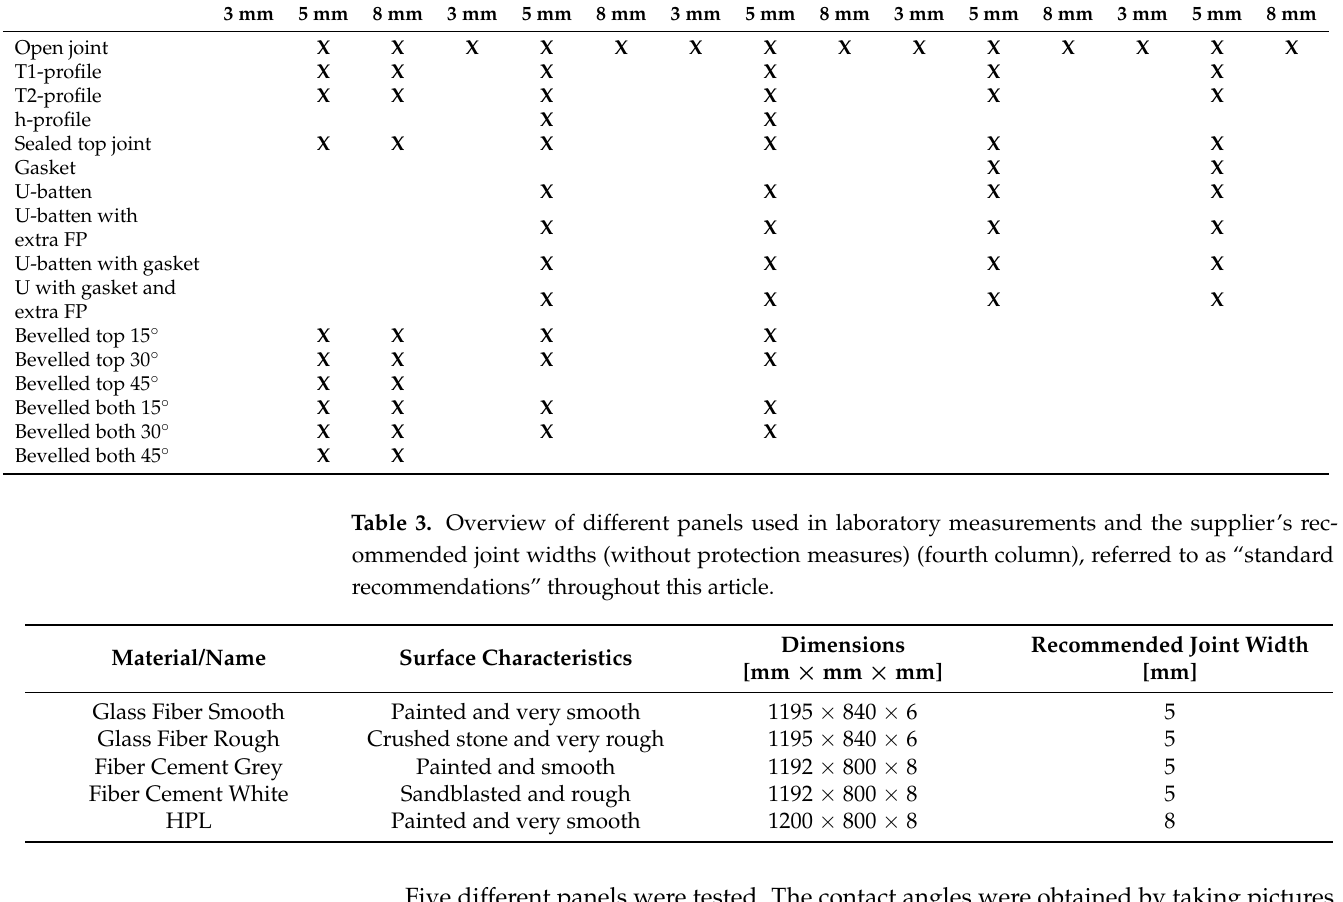
Five different panels were tested. The contact angles were obtained by taking pictures of droplets on the panels (lying horizontally) and thereupon measuring the angles of the droplets. Three different joint widths were tested: 3, 5, and 8 mm. The different joint widths were achieved using spacers. The three aluminium joint profiles tested, referred to as profiles within the joint, are shown in Figure 3. The three profiles’ dimensions are given in Figure 5. Additionally, a gasket and a ventilated U-batten were tested in different combinations, referred to as profiles behind the joint. Figure 6 illustrates three of the combinations. A 70 mm wide gasket with no grooves was used. The U-batten was made of steel with a depth of 15 mm and a height of 70 mm. The U-batten was mounted to the vertical battens; in common practice, vertical battens are not used.